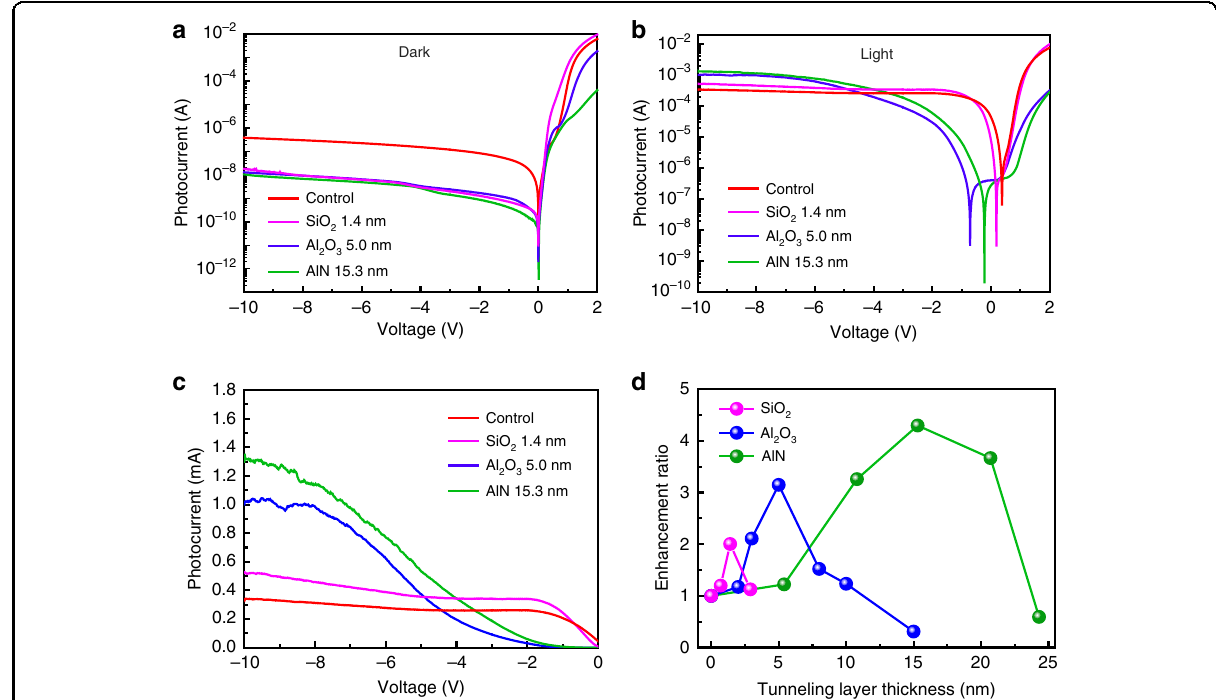
Fig. 5 Comparison of the photo-response for the GIS devices using different insulating materials. I-V characterizations of the three types of graphene/insulator (SiO 2 , Al 2 O 3 , and AlN)/silicon (GIS) photodetectors under a dark and b 365-nm light illumination (12.2 mW cm − 2 ), with the comparison to the conventional GS heterojunction photodetector. The thickness of the insulators used in ( a – c ) for the three types of GIS photodetectors all have been optimized to the best-performed one. c The enlarged illustration of ( b ) in the reverse bias region. d Tunneling layer thickness-dependent photocurrent enhancement for GIS devices with the three kinds of insulator